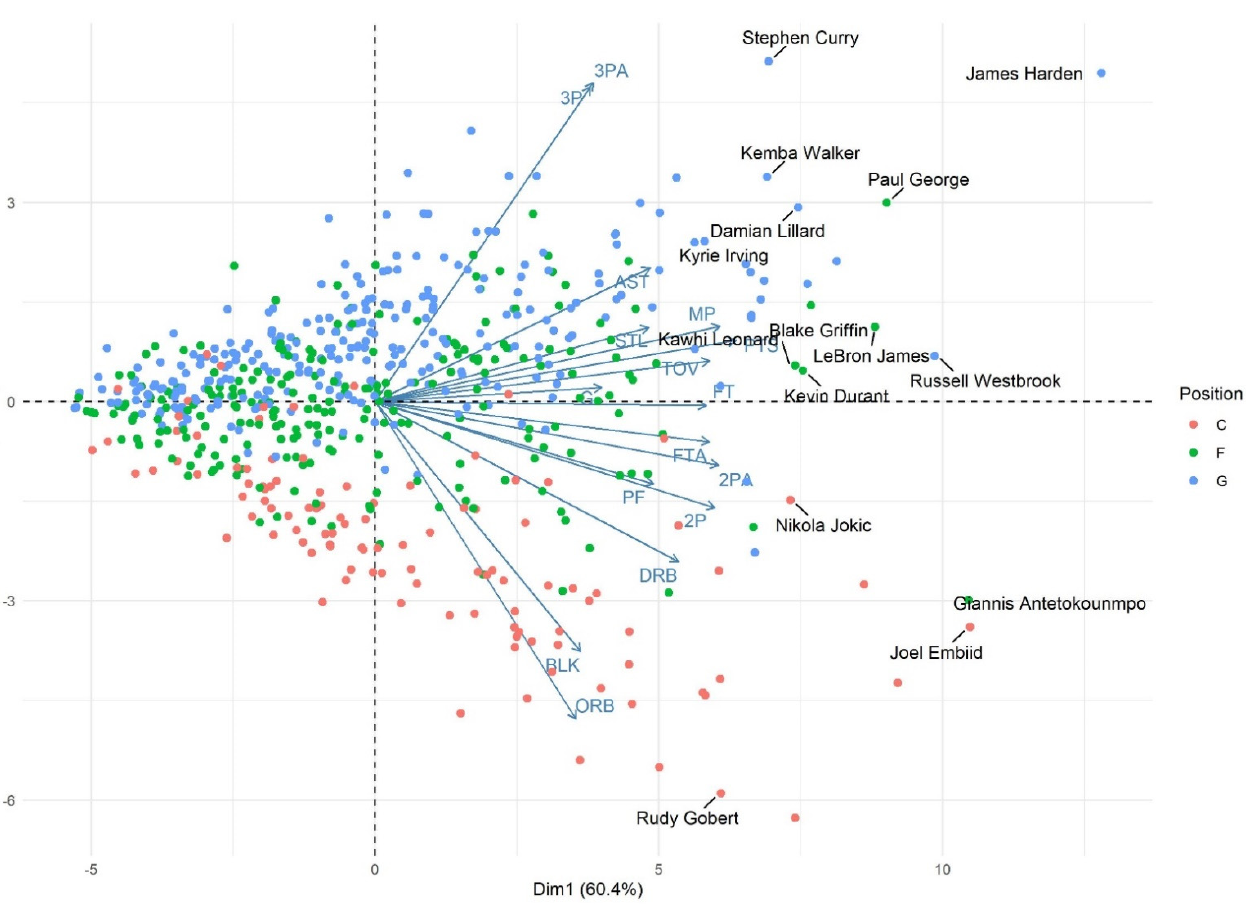
Figure 1. Principal Component Analysis of active players in the 2013 – 14 NBA Season.